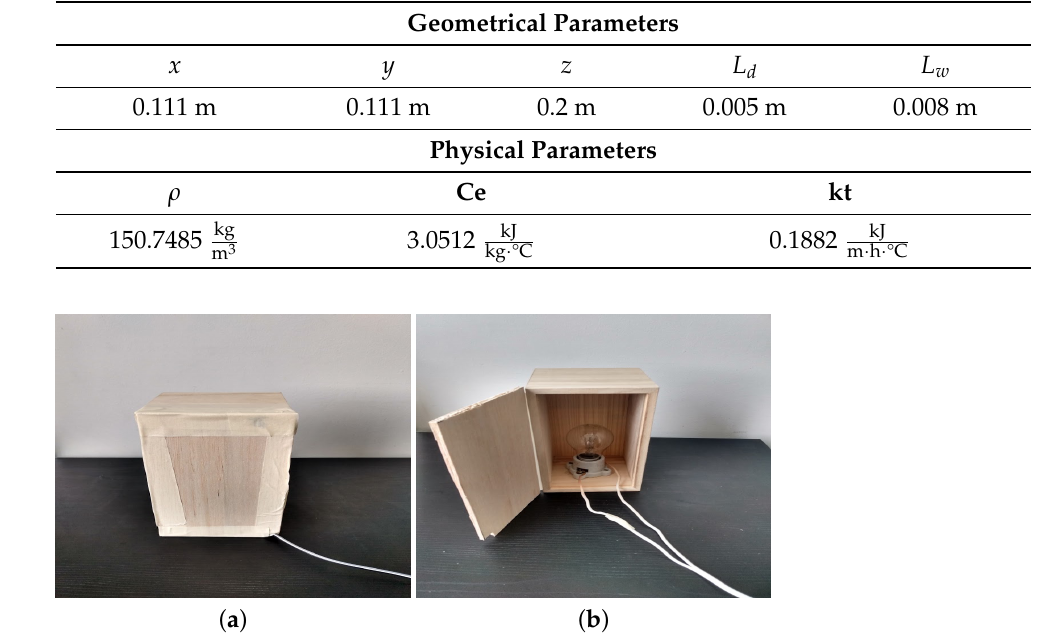
Figure 10. Thermal zone 1 with internal heating load. ( a ) Single thermal zone. ( b ) Single thermal zone with internal load.